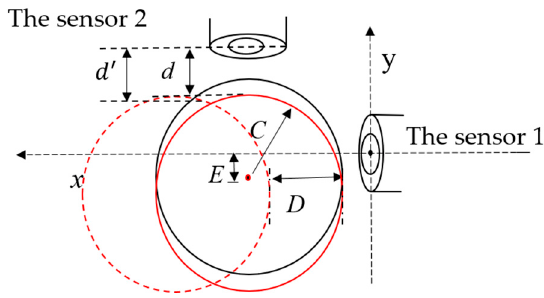
Figure 34. The orthogonal structure mathematical model.